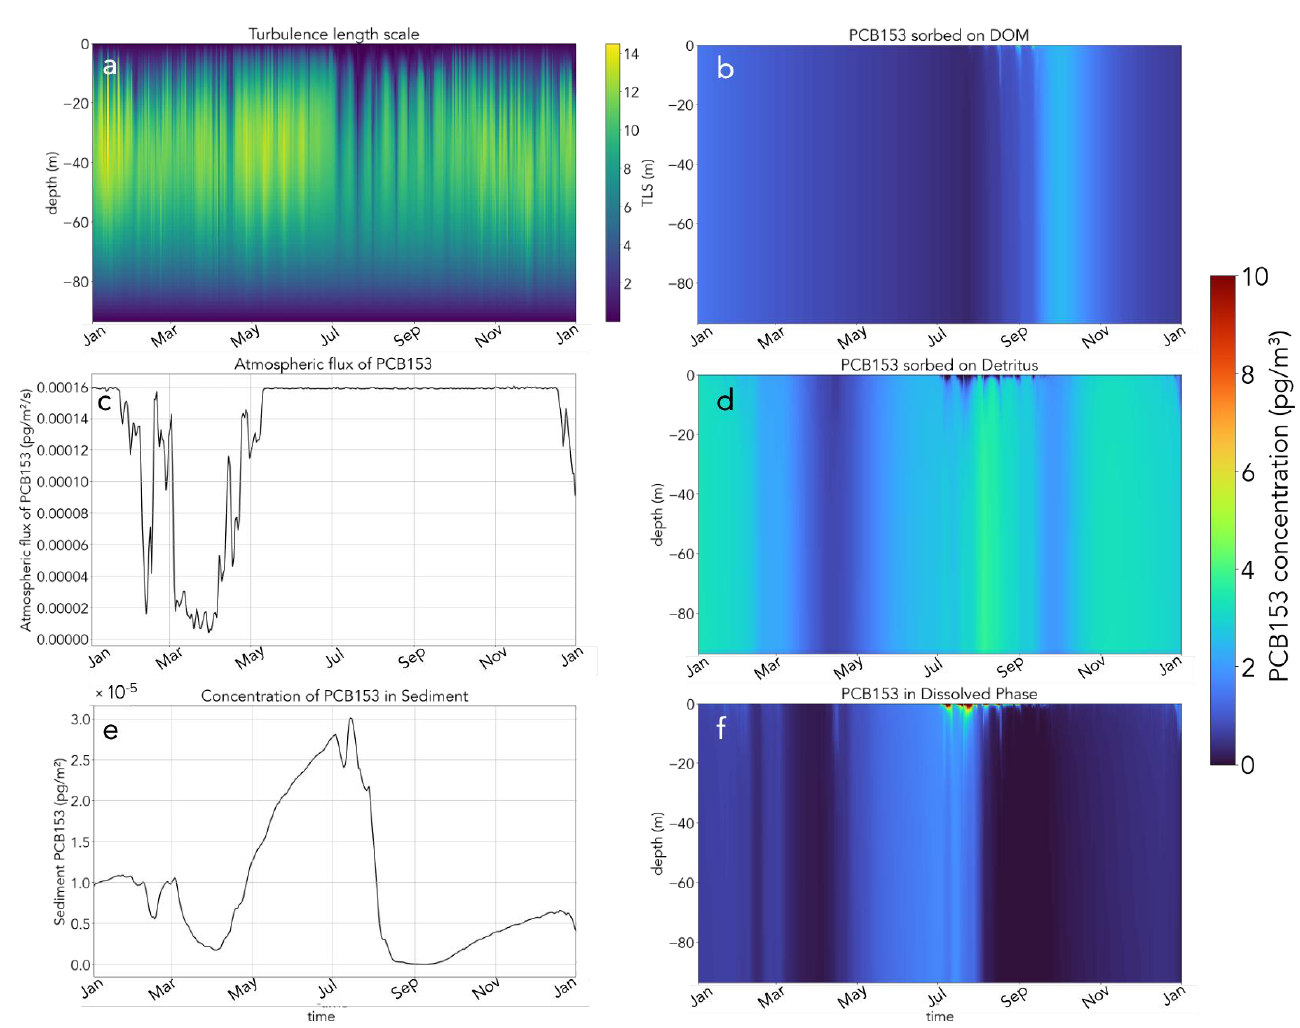
Figure 7. Results of simulation in the Bothnian Bay (year 2001): ( a ) TLS; ( b ) PCB DOM concentrations (pg m − 3 ); ( c ) atmospheric flux of PCB 153 (pg m − 2 s − 1 ) (direction of flux—from atmosphere to water); ( d ) PCB POM concentrations (pg m − 3 ); ( e ) sediment concentration of PCB (pg m − 2 ); ( f ) PCB free concentration (pg m − 3 ).